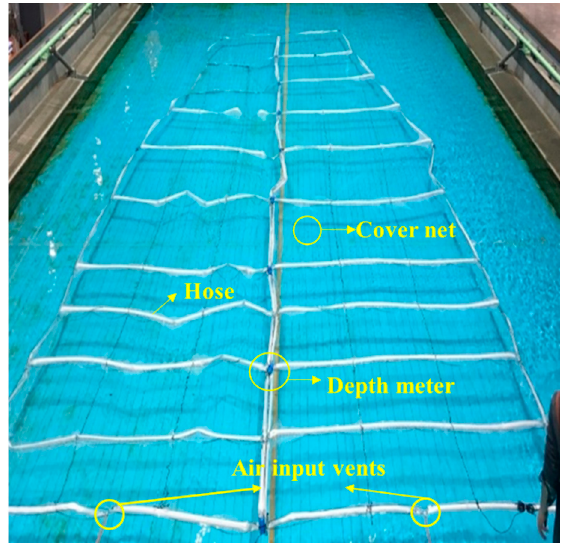
Figure 5. Photograph taken during the experiment.